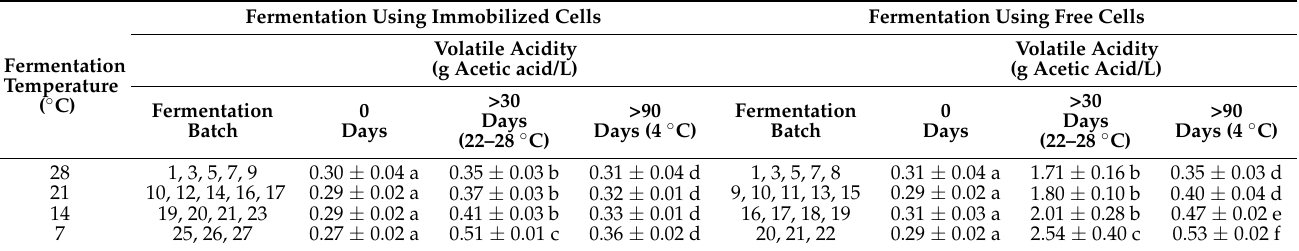
Table 10. Volatile acidity of wines produced from must (12.5 ◦ Be) using immobilized and free cells at 28, 21, 14 and 7 ◦ C and analyzed after storage at 22–28 ◦ C and 4 ◦ C of their